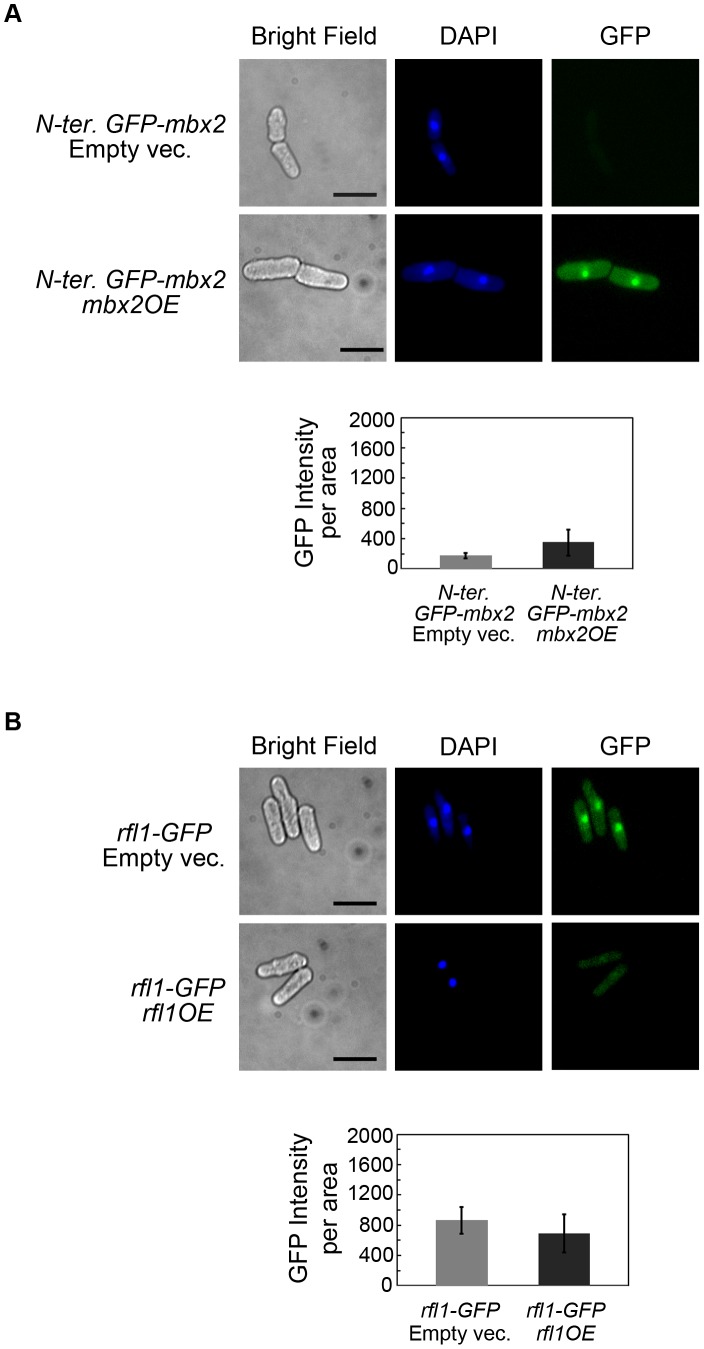

mbx2+ and rfl1+ undergo positive and negative autoregulation, respectively.(A) Positive autoregulation of mbx2+. A strain containing N-terminal GFP-tagged mbx2+ under the control of its native promoter displayed increased GFP expression when mbx2+ was ectopically expressed with the nmt1 promoter. Nuclear GFP-Mbx2 signal and flocs in liquid culture were detected at the 9 hour induction of nmt1-driven mbx2+ in EMM minus thiamine medium. Cells were deflocculated in 2% galactose prior to fluorescence microscopy to facilitate image acquisition. The presence of galactose does not affect the GFP signal (data not shown). The bar graph compares the mean and standard deviation of cellular GFP-Mbx2 signal resulting from nmt1-driven mbx2+ and empty vector control with a significant difference of p<0.001 (Welch's two tailed t-test; n = 50, df = 52). (B) Negative autoregulation of rfl1+. A strain containing C-terminal GFP-tagged rfl1+ under native control exhibited nuclear expression (empty vector). Ectopic expression of nmt1-driven rfl1+ for 18 hours in EMM minus thiamine medium reduced the nuclear GFP signal with a slight increase in cytoplasmic GFP signal. The bar graph compares the mean and standard deviation of overall cellular Rfl1-GFP signal resulting from nmt1-driven rfl1+ and empty vector control with a significant difference of p<0.01 (Welch's two tailed t-test; n = 27, df = 44). Cells were stained with DAPI to visualize nuclei. Scale bar, 10 µm.